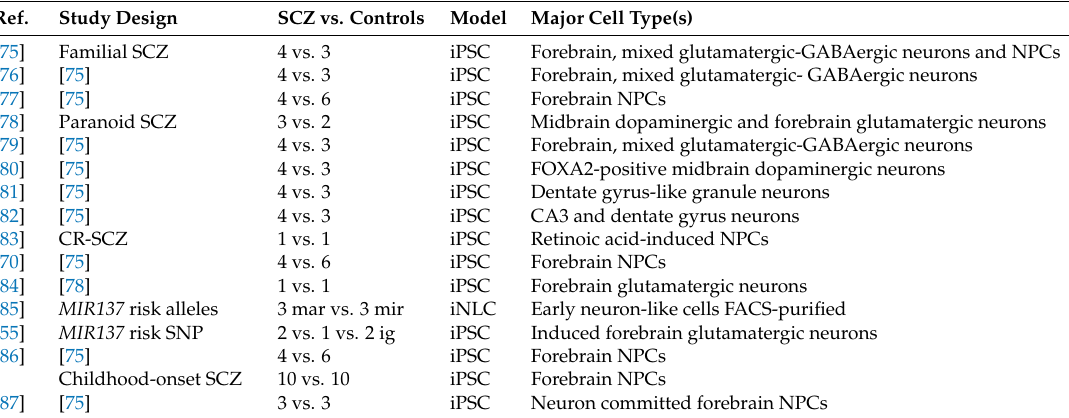
Table 2. Study design, cellular model, and neuronal cell types.